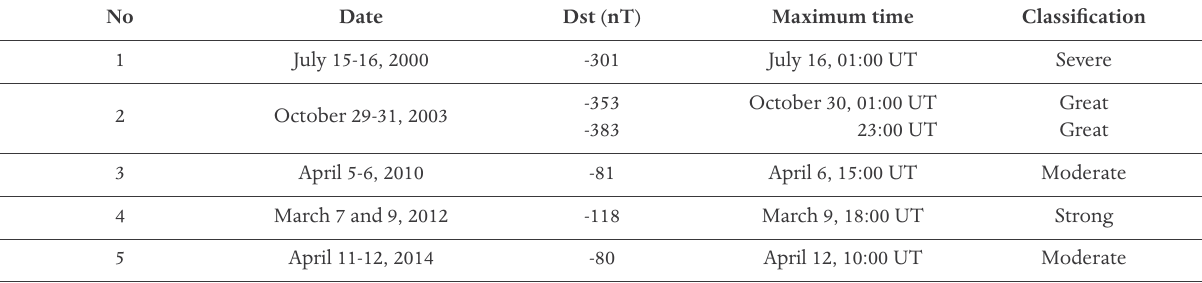
Table 2. List of geomagnetic storm events used in GMIST